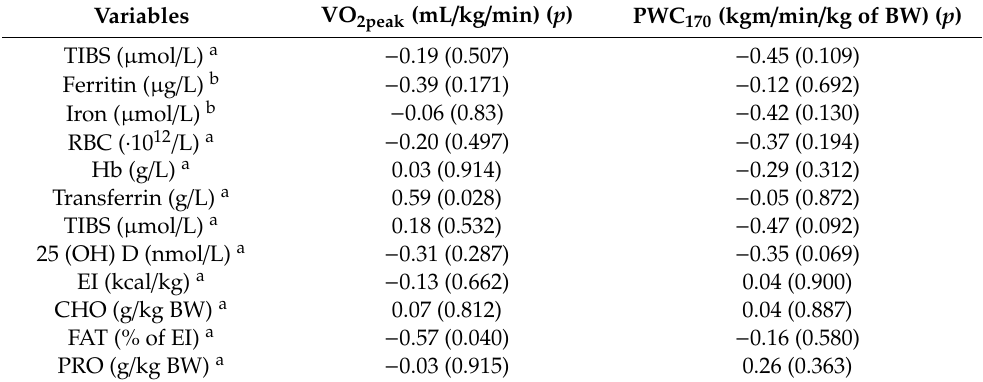
Table 7. Correlation between haematology profile, dietary intake, and physical capacity (VO 2peak and PWC 170 ).